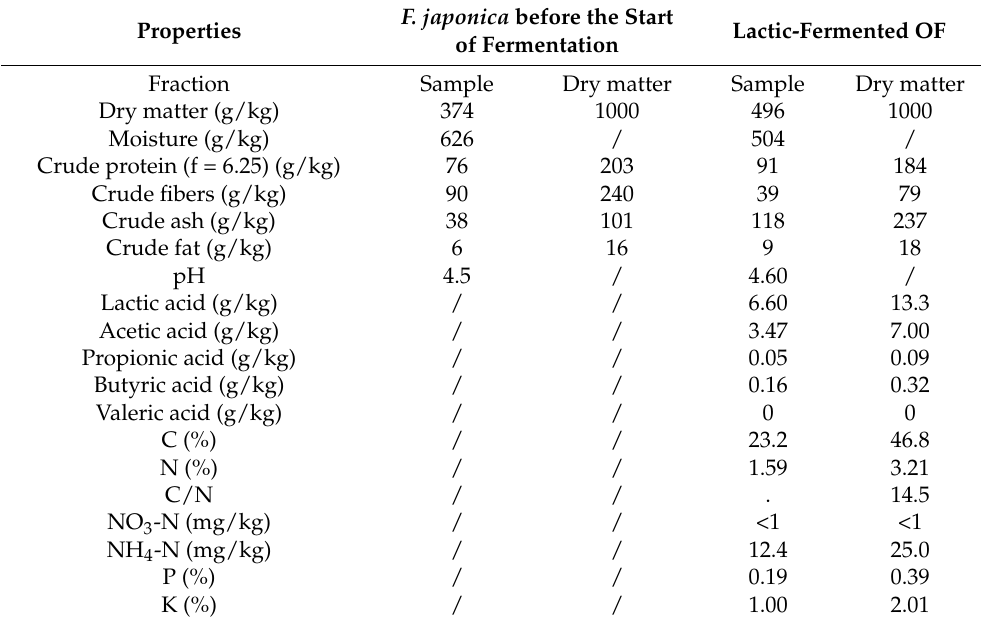
Table 2. Properties of organic fertilizer (OF) made of F. japonica and Bokashi compost starter mixture before and after lactic